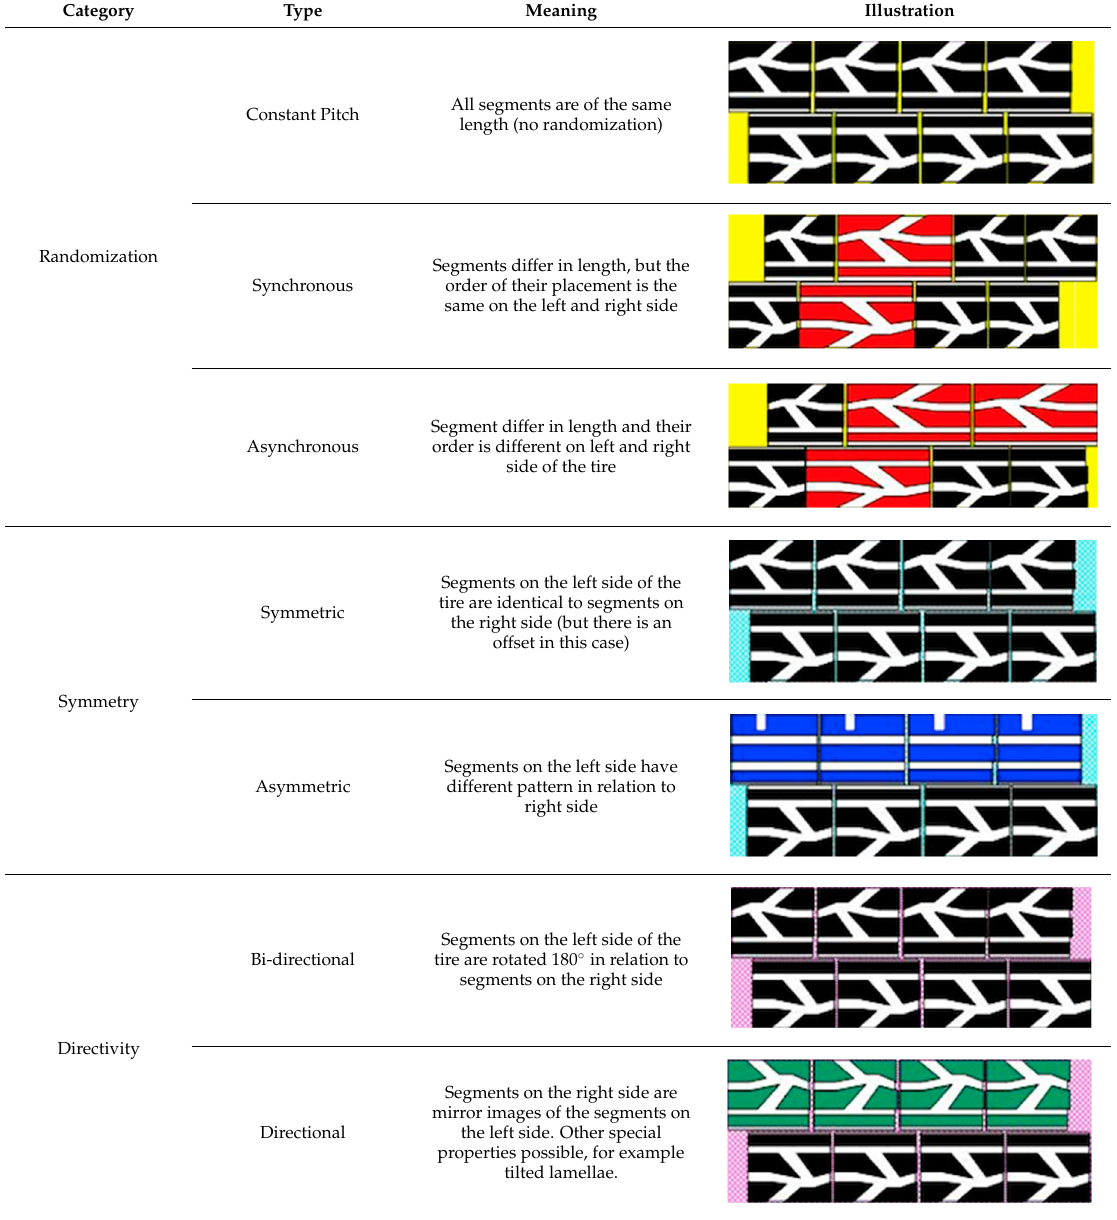
Table 9. Different layouts of tire segments and principles of randomization (source from Sandberg and Ejsmont, 2002 [1], Table 10.2; reprinted with permission from Dr. Ulf Sandberg of VTI, Sweden).